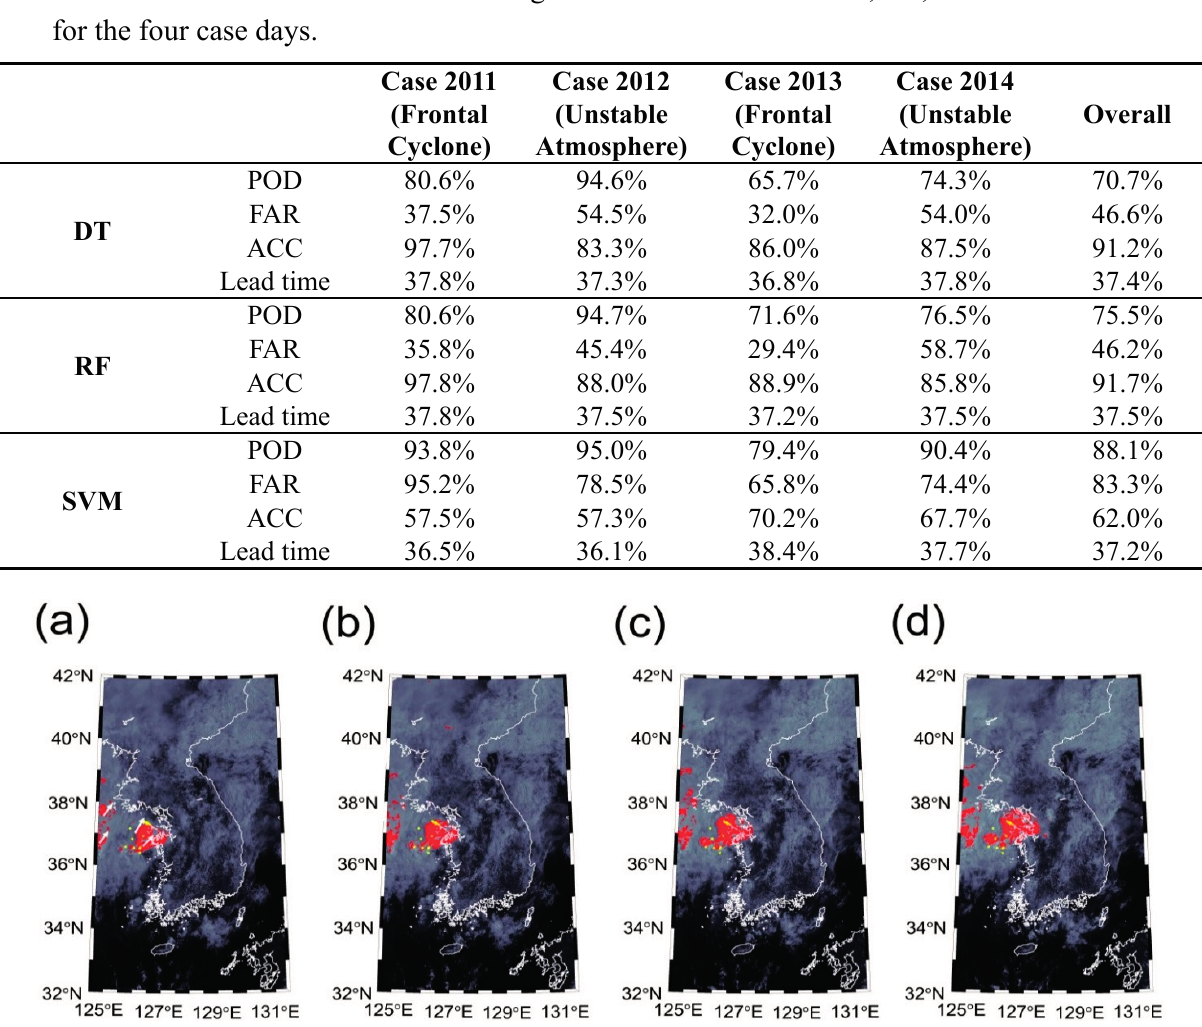
Figure 5. CI detection maps for the case in 2011 (CI by frontal cyclone) generated from the RF model, overlaid with COMS MI IR1 images obtained ( a ) 60 min, ( b ) 45 min, ( c ) 30 min., and ( d ) 15 min before the image acquisition at the nearest time of the lightning occurrence. Red objects are the predicted CI and yellow dots represent the location of lightning occurrences. White arrows in (a) represent the movement directions of cloud